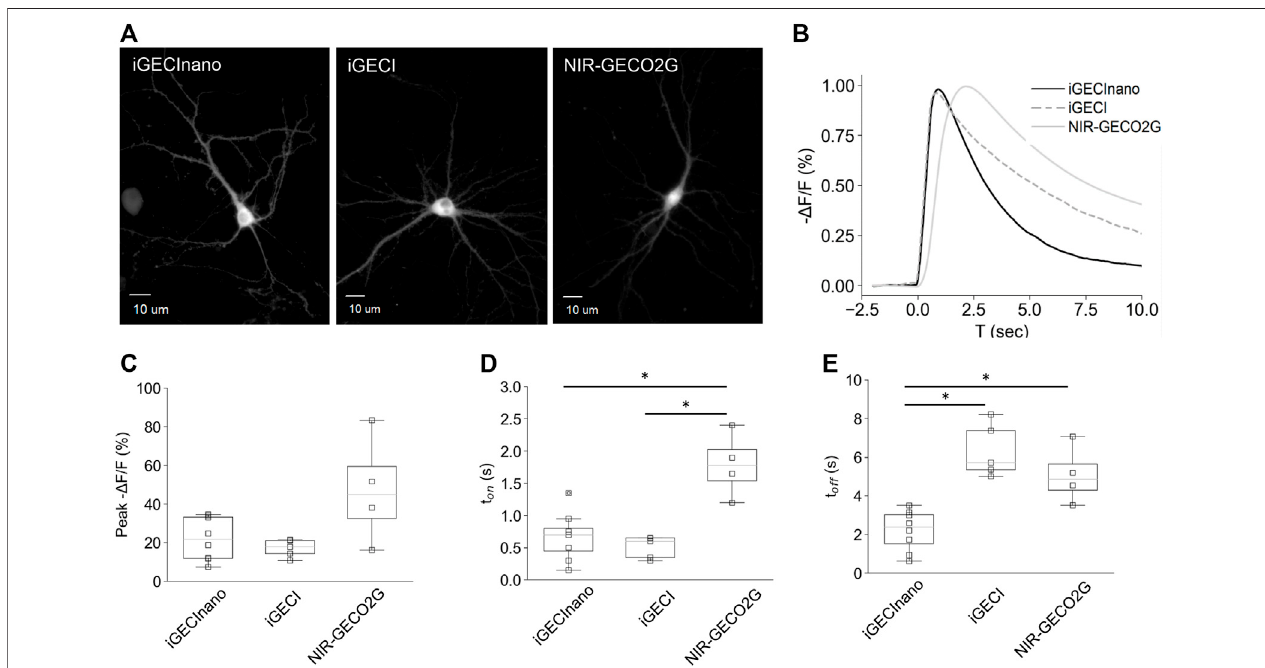
FIGURE4| PerformanceofiGECInanoinculturedprimarymouseneurons. (A) ImagesofneuronsexpressingNES-iGECInano,NES-iGECI,andNIR-GECO2G. (B) Normalized fl uorescencechangerecordedfromcellsexpressingiGECInano,iGECI,andNIR-GECO2Gevokedwithasinglepulseofelectricstimulation(tracesrepresent the mean value). (C – E) Box plots showing peak fl uorescent (C) , time topeak (t on ) (D) , and decay time (t off ) ofthe evoked responses (B) . Box plots show median, 25and 75 quartiles, and max and min values. Statistical signi fi cance ( p < 0.05, Kruskal – Wallis and Dunn ’ s multiple comparison test) is shown with an asterisk (*). Cells per condition: iGECInano ( n = 8), iGECI ( n = 5), NIR-GECO2G ( n = 4).